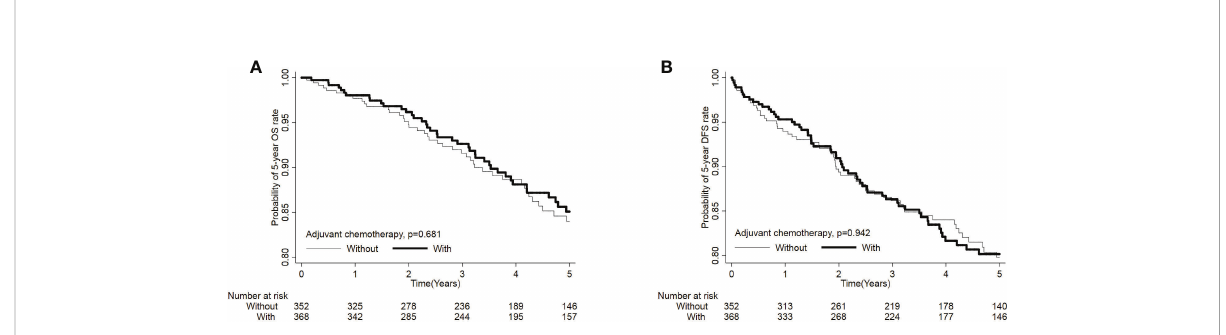
FIGURE 2 Probability of overall survival (A) and disease-free survival (B) in rectal cancer patients with good response (ypT0-2N0) after nCRT and surgery,